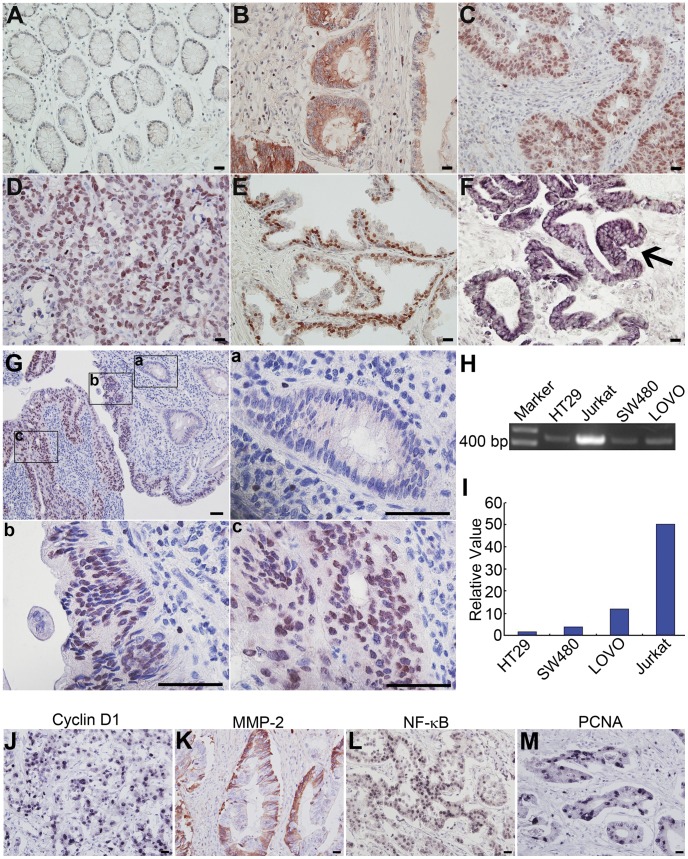
SATB1 expression in CRC tissues and cell lines.
A–E: SATB1 protein expression (positive signals show red staining with AEC) in matched normal colorectal epithelium (A); and well (B), moderately (C) and poorly differentiated (D, E) CRC tissues. In normal colon tissue (A) positive staining is seldom found in the normal glandular epithelium. T lymphocytes in the lamina propria are positive. In CRC tissues (B–E) positive signals for SATB1 are distributed in the cytoplasm or in nuclei or both in carcinoma epithelial cells. F: Expression of SATB1 mRNA in cytoplasm of CRC cells (arrows, purple signals stained with NBT/BCIP). G: SATB1 protein expression in one sample of CRC tissue and in the peri-tumoral tissue (red signals stained with AEC). a, b and c are higher magnifications of the corresponding regions in the upper left panel. SATB1 is negative in the peri-tumoral normal glandular epithelium (a). More cancer cells are positive for SATB1 in the central zone of the neoplasm (c) than in the periphery (b) of the cancer and normal tissue. H: Agarose gel electrophoresis of RT-PCR amplification products following mRNA extraction from three cell lines and a positive control. I: Relative levels of SATB1 in CRC cell lines using qRT-PCR. J–M: Cyclin D1(J), MMP-2(K), NF-κB (L) and PCNA(M) expression in CRC tissues (J, L, M: purple signals stained with NBT/BCIP; K: red signals stained with AEC). Bars = 50 µm.